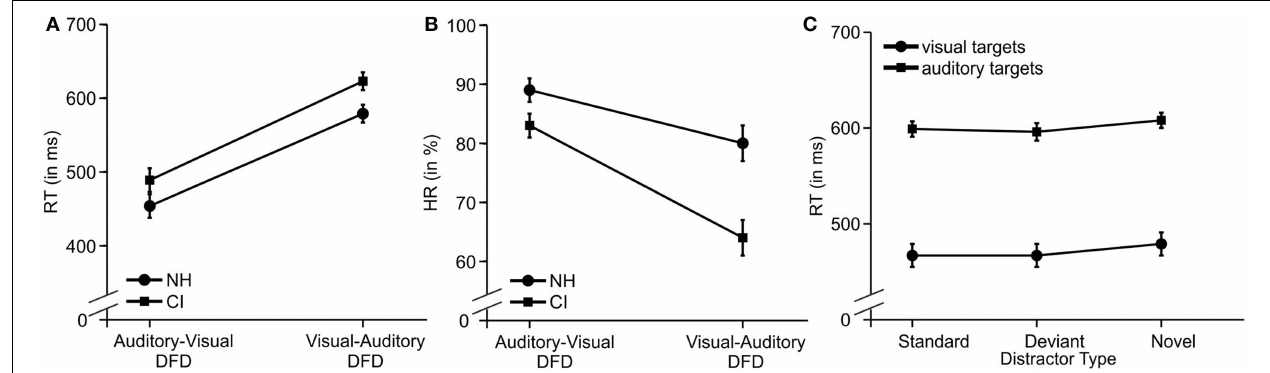
FIGURE 2 | The behavioral results. (A) Main effect for Modality and for Group regarding RT. (B) Interaction for Group x Modality regarding HR. (C) Main effect for Distractor Type on RTs in the auditory-visual DFD (visual targets) and the visual-auditory DFD (auditory targets). Error bars denote the standard error of the mean.